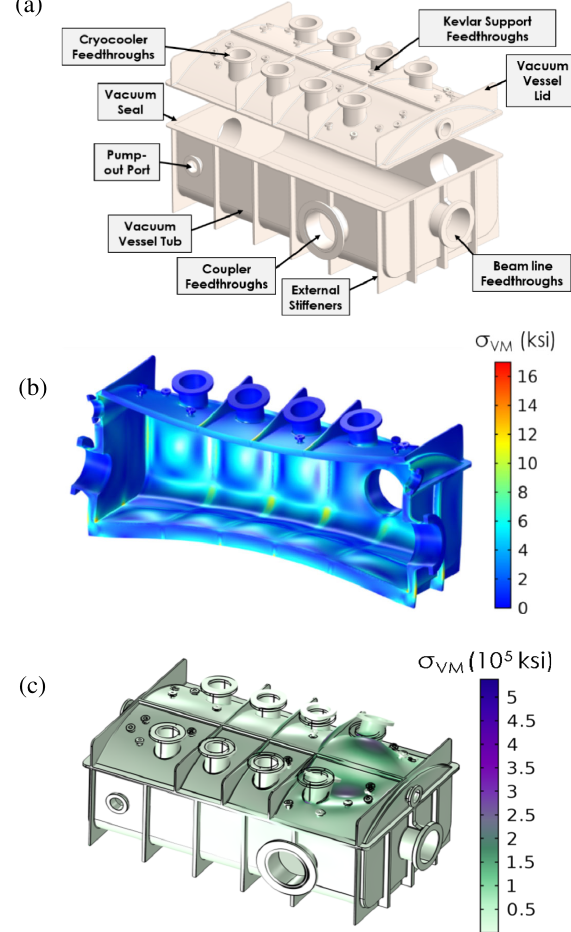
FIG. 24. (a) CAD view of the cryostat vacuum vessel made of a large tub and a lid that are sealed together. (b) Distribution of von Mises stresses due to vacuum loading (displacements exagger- ated 130-fold). (c) The von Mises stresses in the vacuum vessel when the first buckling failure mode occurs on one side of the lid. The loading required for this mode of failure is approximately 64 times larger than under normal